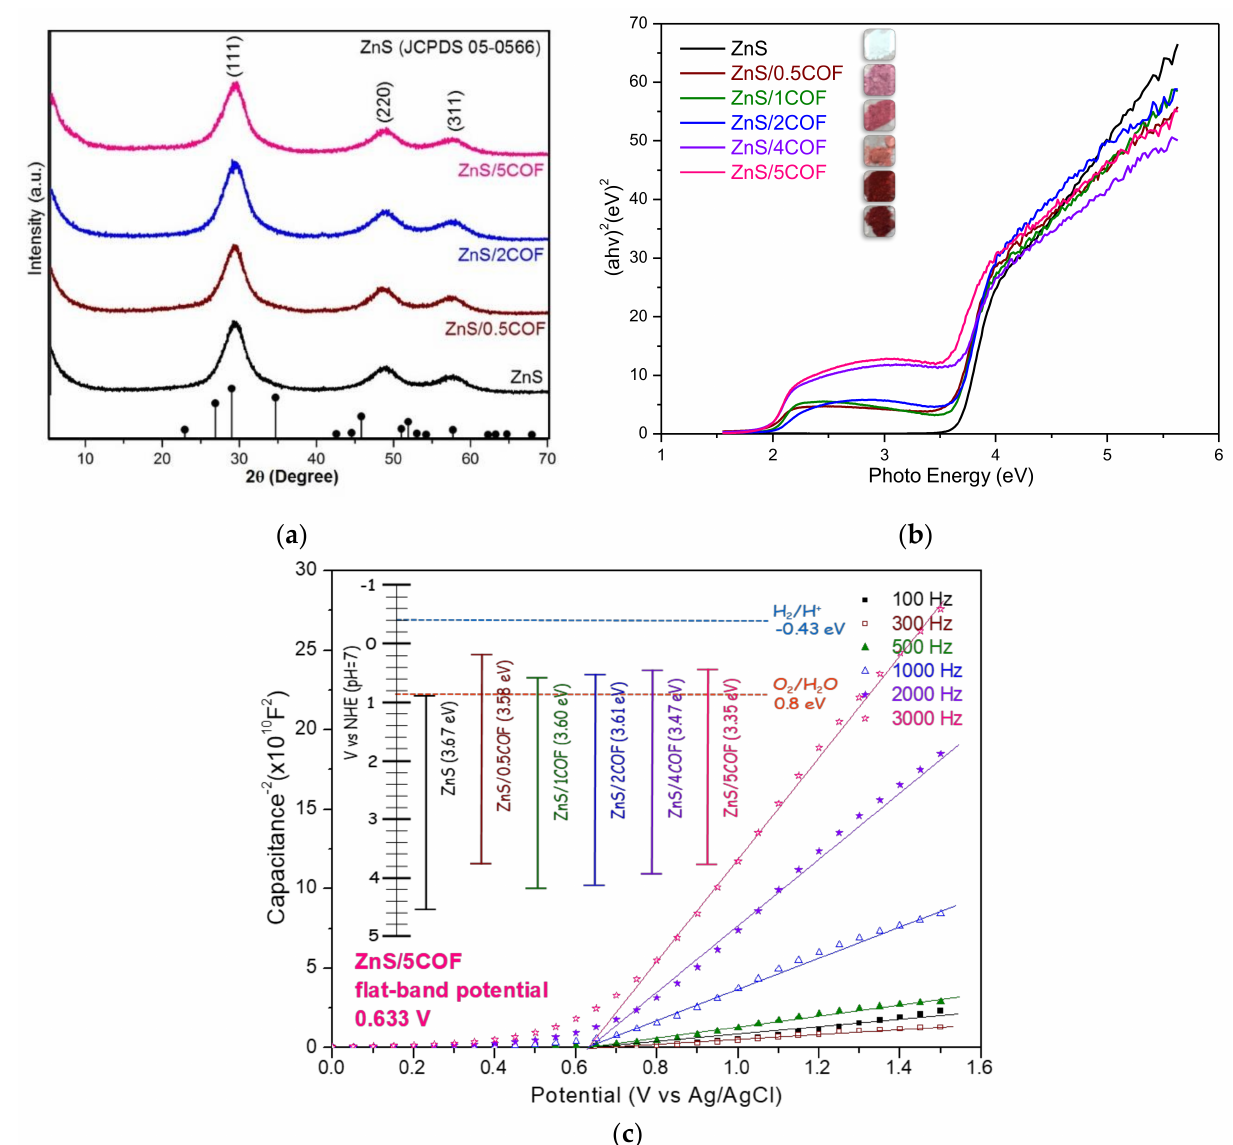
Figure 3. ( a ) XRD patterns, ( b ) UV-Vis spectrum, and ( c ) Mott–Schottky plots of ZnS/COF composite photocatalyst with different COF